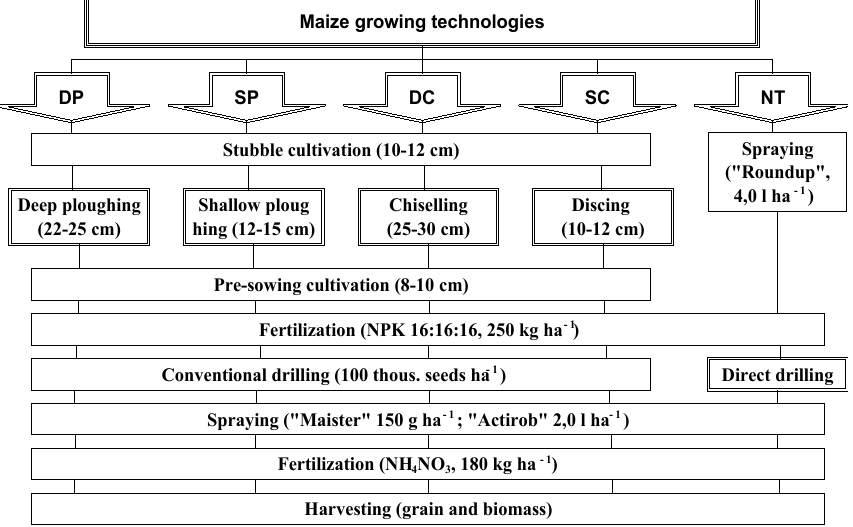
Fig. 2. Technological scheme for maize cultivation according to Šarauskis et al.